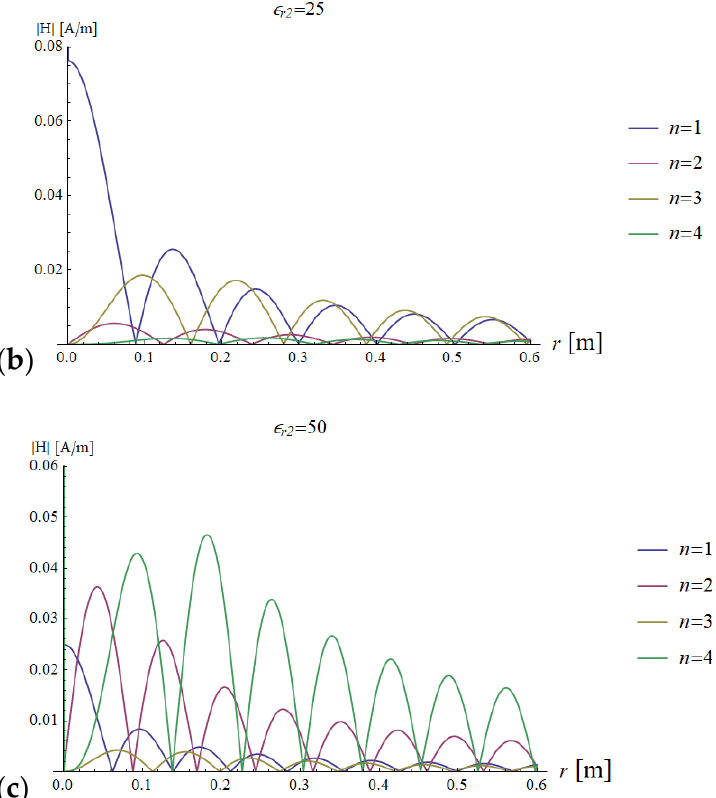
Figure 12. Magnetic field distribution as a function of the radial coordinate in a lossless ( σ = 0 S/m) sphere of radius 𝑎 = 0.6 m for the first four modes. Results are shown for different values of relative permittivity ( 𝜀 𝑟2 = 5, 25 and 50 in ( a – c ), respectively).